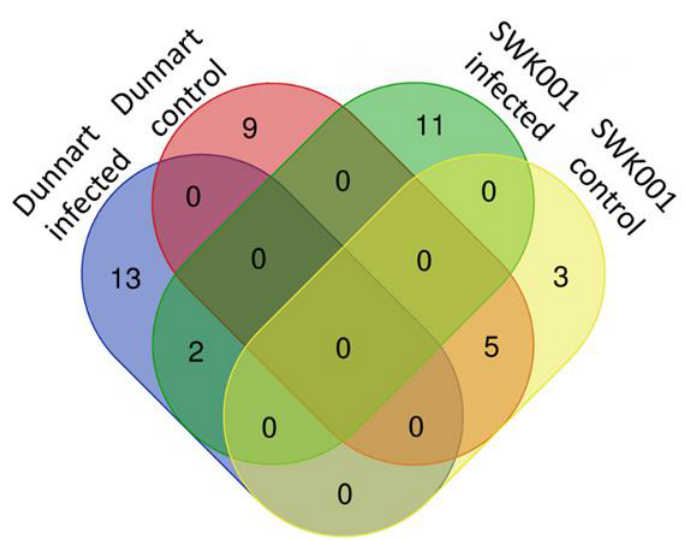
Figure 7. Venn diagram displaying the partial overlap and differences of the statistically significant discriminatory metabolites selected from the OPLS-DA models. Extracts from the infected and control groups of the respective cultivars (tolerant “Dunnart” and susceptible “SWK001”) are compared. The numerical values in the diagram represents the discriminatory metabolites (Table 1) that are unique to the respective cultivars or treatments and conversely, also shared between the cultivars or treatments.